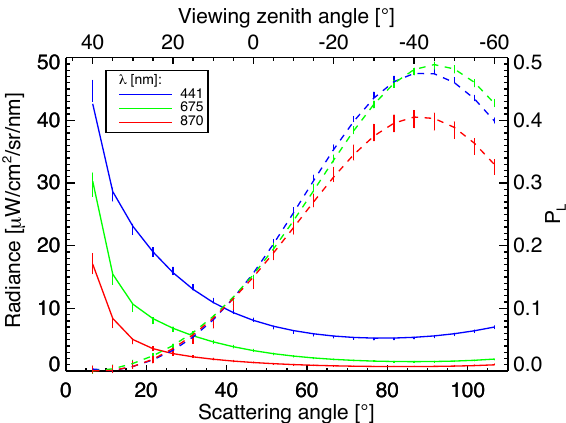
Figure 6. Aerosol optical thickness at 550 nm during the day of July 9, 2013, at Cabauw, the Netherlands. GroundSPEX diffuse sky measurements are compared with AERONET direct sun measurements. The red data point at 14:55 UTC is retrieved from the measurements displayed in Fig. 5.